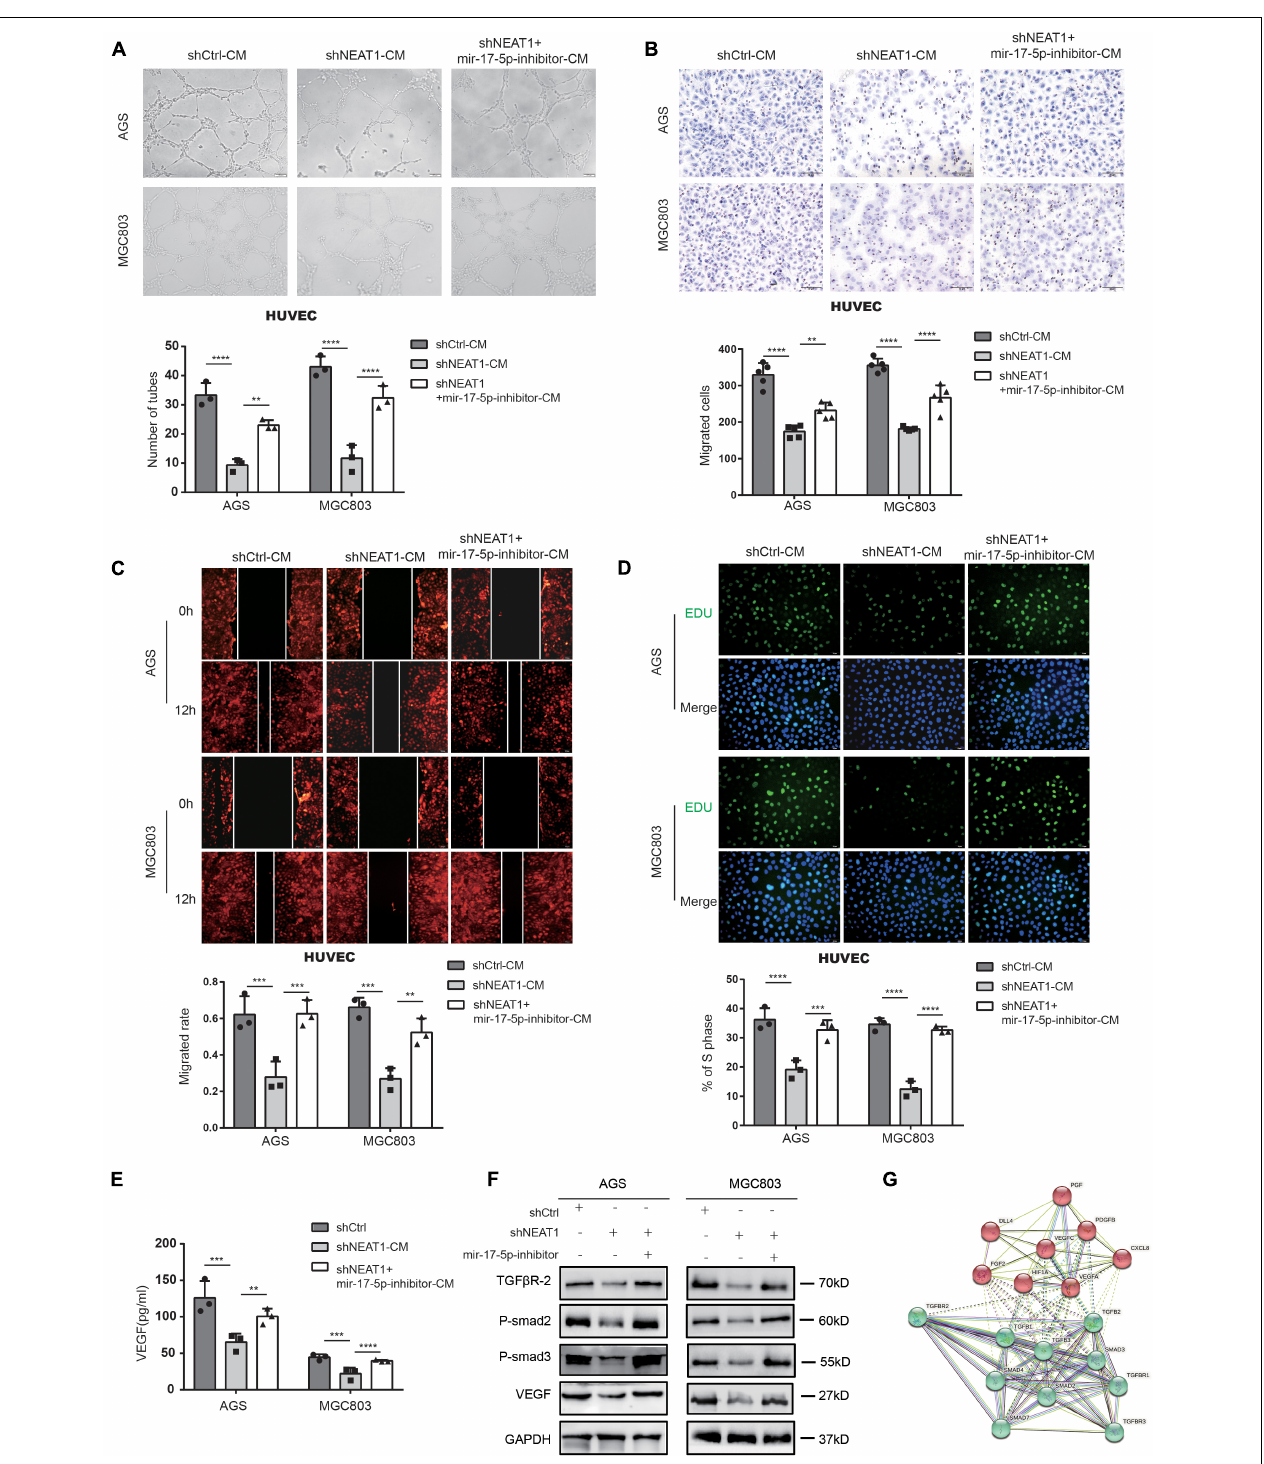
FIGURE 4 | Repressing miR-17-5p reverses suppressive effect of silencing NEAT1 on malignant phenotypes of GC in vitro. (A) Effects of miR-17-5p inhibitor on NEAT1 mediated GC angiogenesis through tube formation assay. (B,C) Effects of miR-17-5p inhibitor on NEAT1 mediated HUVEC migration through transwell (B) and wound healing assay (C) . (D) Effects of miR-17-5p inhibitor on NEAT1 mediated HUVEC proliferation through EdU assay. (E) Effects of miR-17-5p inhibitor on secretion changes of VEGF modulated by LncRNA NEAT1 through ELISA assay. (F) Effects of miR-17-5p inhibitor on expression changes of TGF- β /smad pathway proteins (P-smad2, P-smad3 and VEGF) modulated by LncRNA NEAT1 through western blot assay. (G) The PPI network of TGF- β /smad pathway-related proteins and classsical proangiogenic factors associated with TGF β R2 alterations in String analysis. ** P < 0.01, *** P < 0.001, **** P < 0.0001.